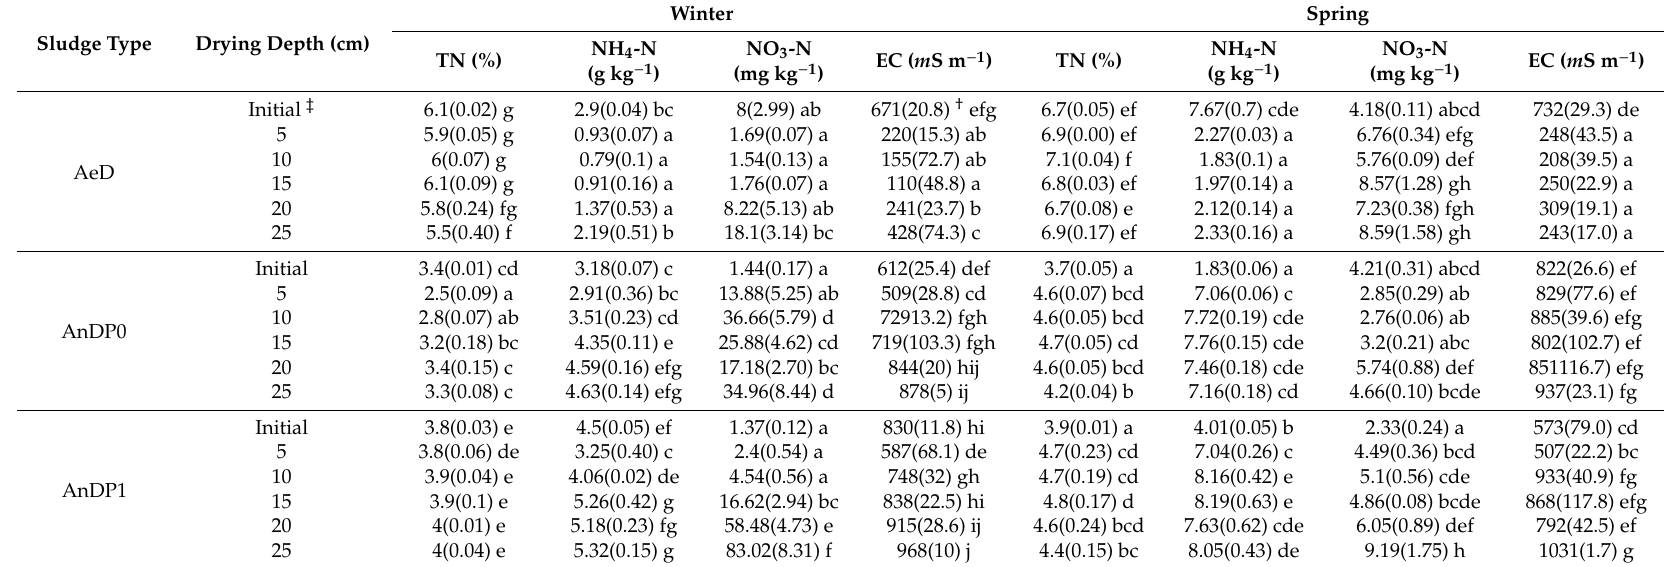
Table 2. Changes in N and electrical conductivity (EC) as influenced by the interaction e ff ects of sludge type and drying depth during sludge drying in winter and